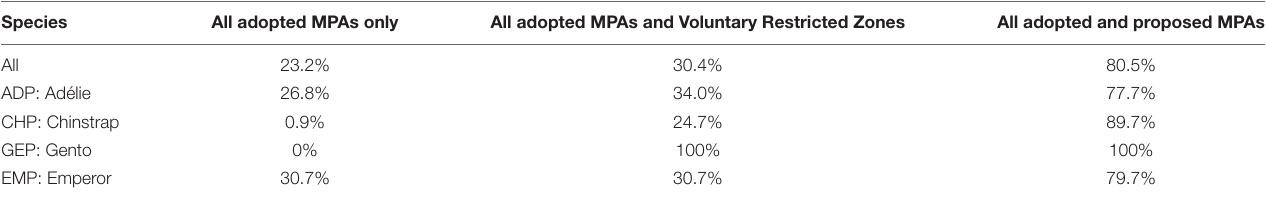
TABLE 3 | Percentage of all, and species specific marine IBAs, which overlap with the network of key management areas (adopted and proposed MPA network, and the Voluntary Restricted Zones) considered within the study area (MPA planning domains 1, 3, 4, 7, 8, and 9). Species